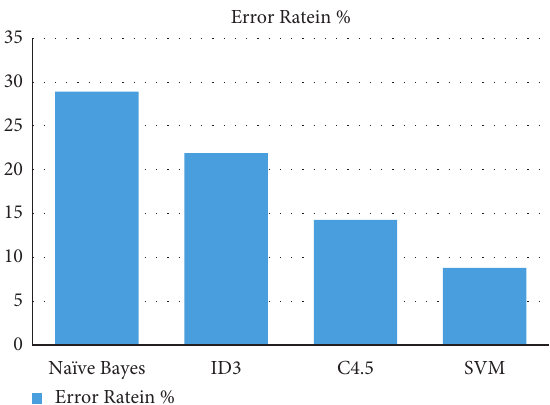
Figure 5: Error rate results of classification